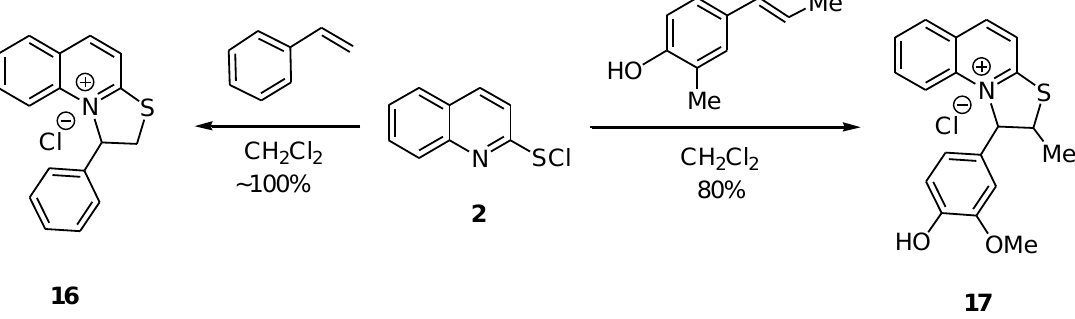
Why do annulation reactions of quinolinesulfenyl chloride 2 with styrene,